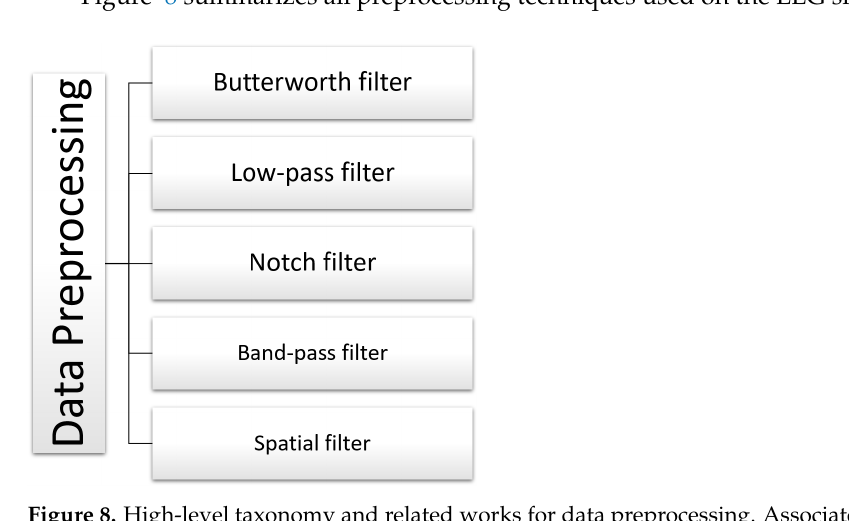
Figure 8. High-level taxonomy and related works for data preprocessing. Associated bibliographic references: butterworth filter [59,66,69,79], low-pass filter [60,65], notch filter [62,68,75], band-pass filter [63,70–73,76,77], and spatial filter